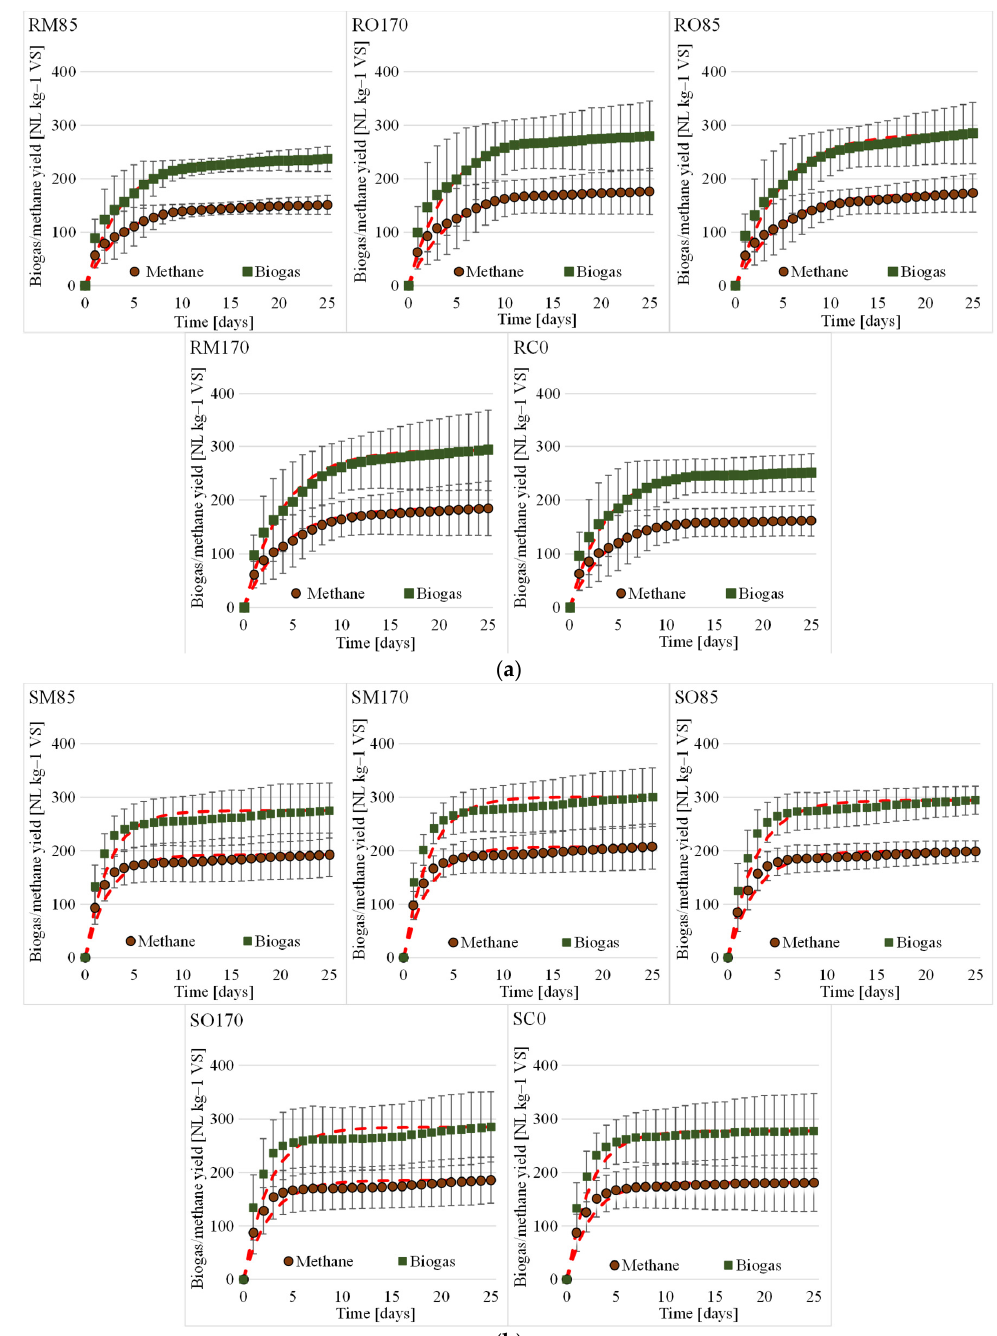
Figure 3. Cumulative biogas and methane yield (NL kg − 1 VS) of Helianthus salicifolius as silage and raw biomass in the 25-day test, depending on the type of fertilization (kg N ha − 1 ): C0—without fertilization, O85—organic fertilization 85, M85—mineral fertilization 85, M170—mineral fertilization 170, O170—organic fertilization 170. ( a ) Helianthus salicifolius as raw biomass (R); ( b ) Helianthus salicifolius as silage (S).